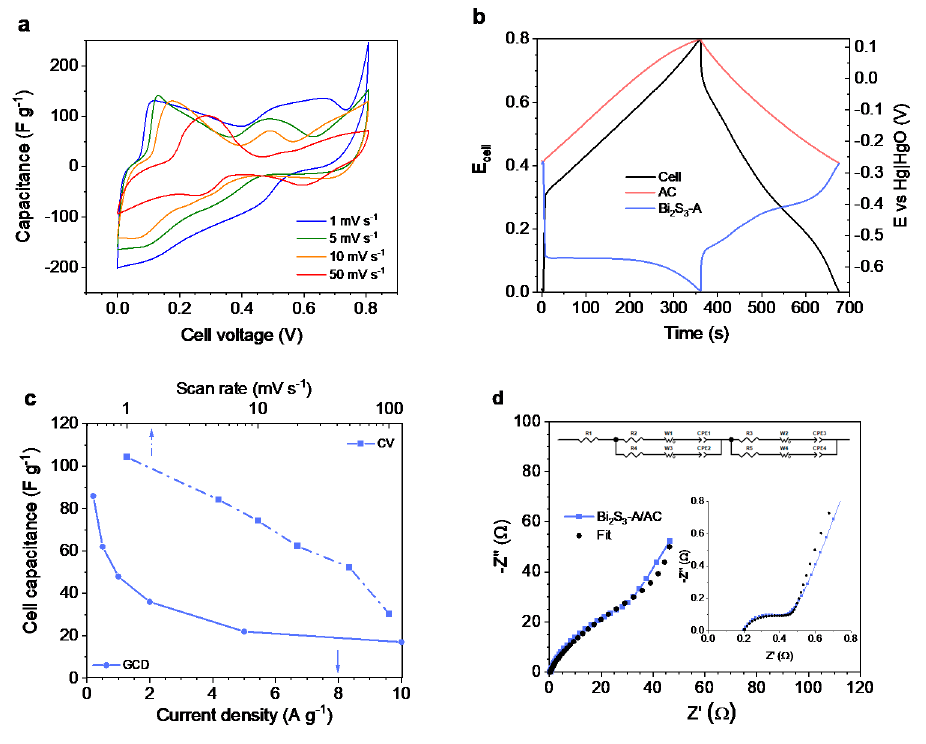
Figure 8. CV curves at the different scan rates ( a ), GCD curves at a current density of 0.2 A g − 1 ( b ), cell capacitance versus scan rate/discharge current density ( c ), and the Nyquist plot with an inset representing the high-frequency range and the equivalent circuit diagram ( d ) of the hybrid capacitor based on the Bi 2 S 3 -A and AC electrodes.